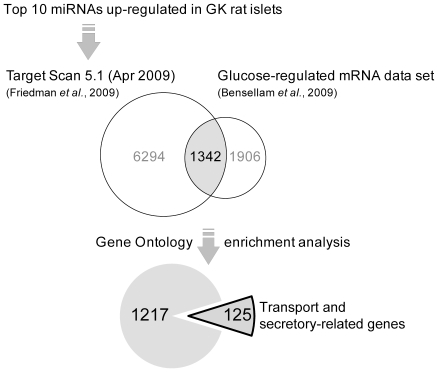

In silico strategy to analyze the miRNAs upregulated in the GK rat islets.One of the highlights of the approach is the filtering of predicted targets with known glucose-regulated mRNA data set from a previous study, significantly reducing false positive targets. This also resulted to a more focused enrichment of genes already implicated in islet functions.